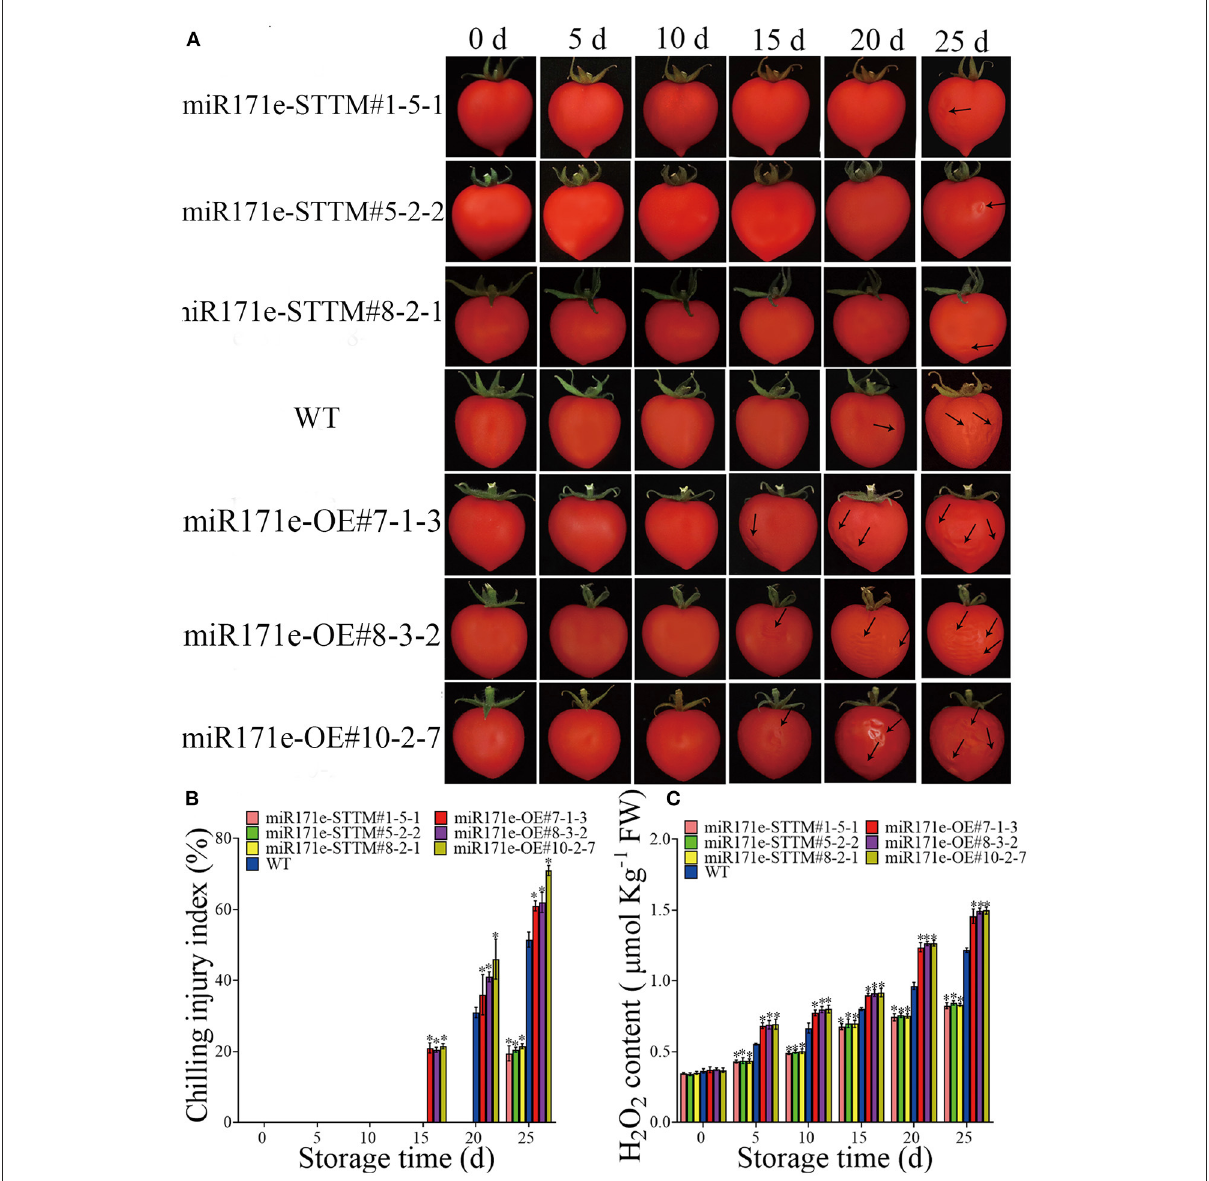
FIGURE1 The CI and phenotypic characterization in tomato fruit at MR stage. (A) The H 2 O 2 content of tomato fruit at MR stage. (B) The CI index of tomato fruit at MR stage. (C) Vertical bars represent standard deviations of the means, n = 3. Asterisks indicate the statistical difference in the significance at * p <